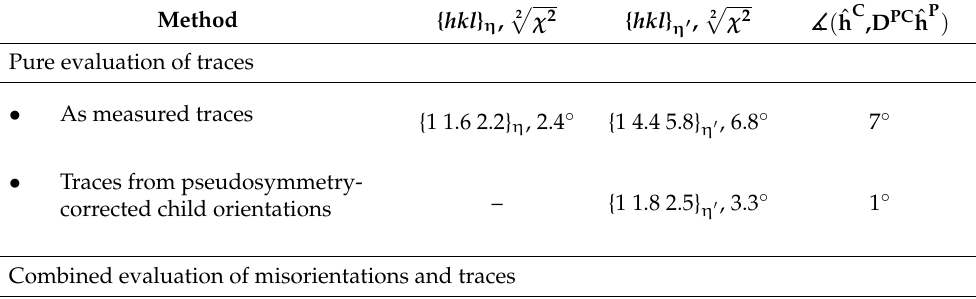
Table 3. Indices of the η (parent, P) habit planes { hkl } η and η (cid:48) (child, C) habit planes { hkl } η (cid:48) ; angular (cid:112) χ 2 of the traces from the habit planes; and angular deviation of the habit planes ˆ h deviation 2 P from D PC ˆ h determined by the different methods and adjusted data sets. Note that for ease of comparability of habit planes, h is normalized to